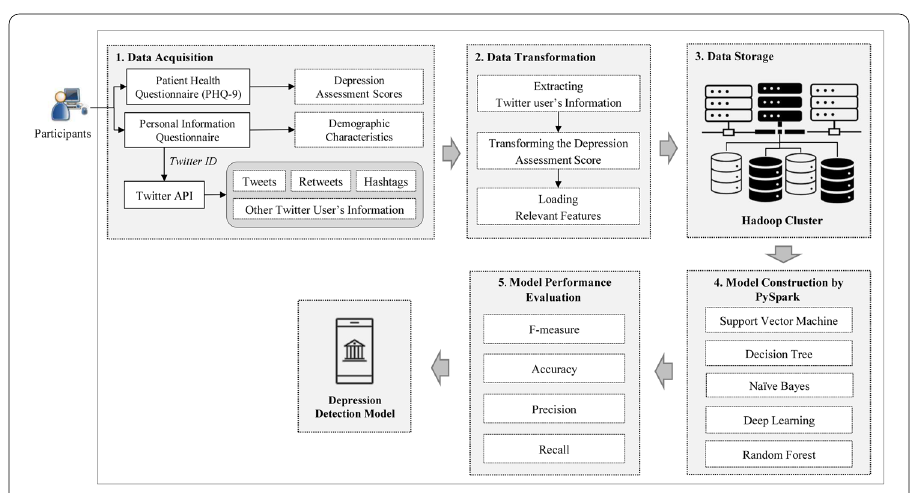
Fig. 2 The framework of a depression detection